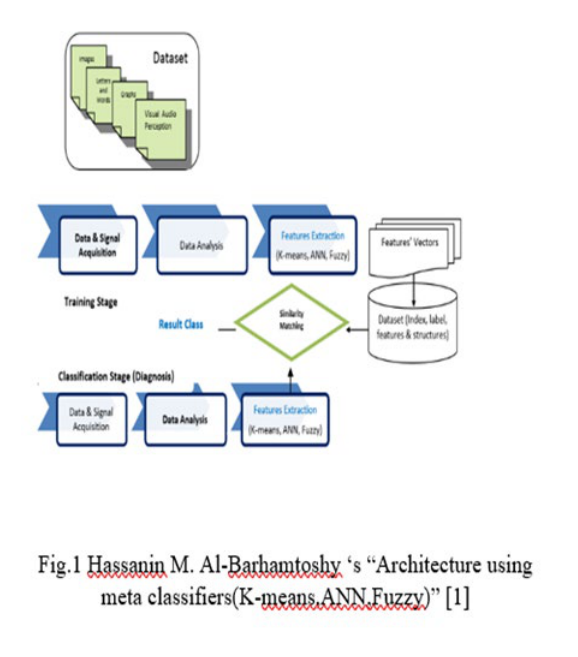
Table 1. Differences of mean and variance values of dyslexic, healthy and